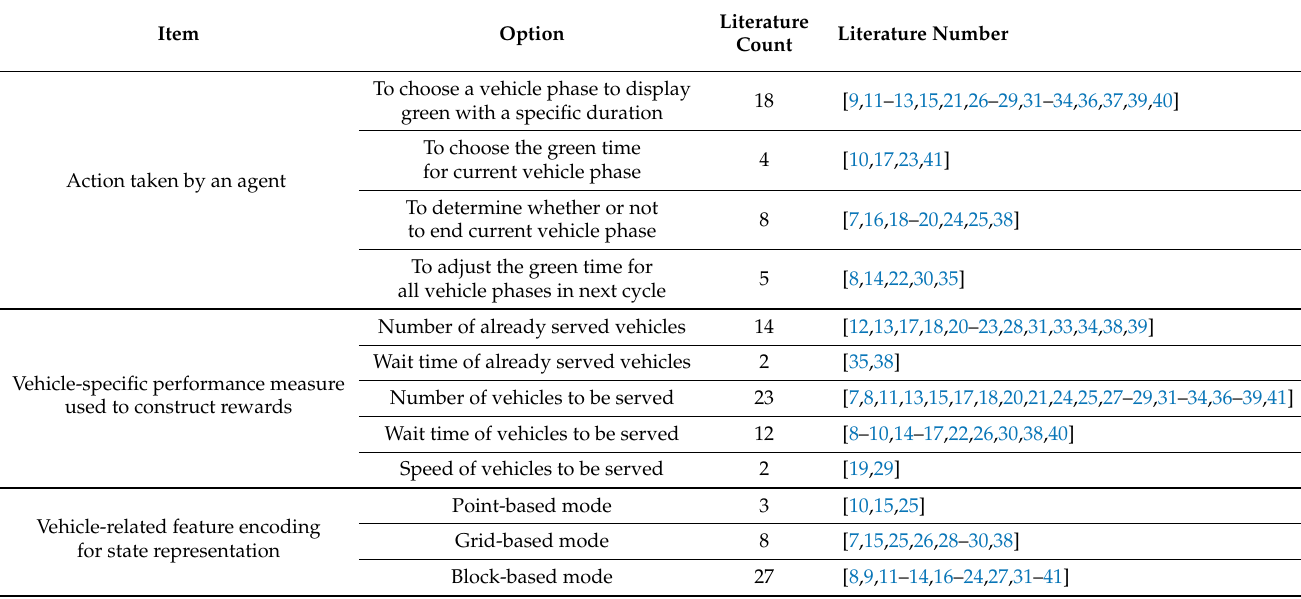
Table 1. Literature groups with regard to RL